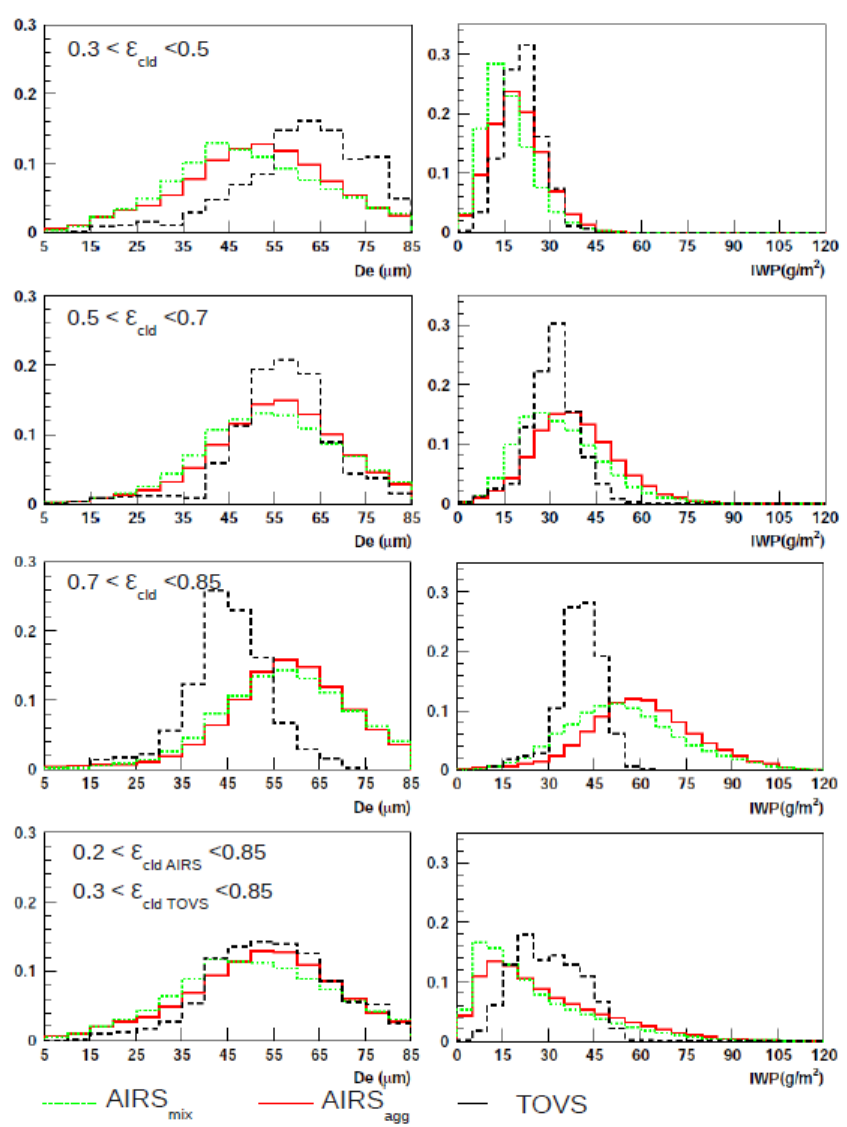
Fig. 14. Normalized frequency distributions of D e (left) and IWP (right) retrieved from TOVS (dashed black lines) and from AIRS observations (dotted green), separately for different cirrus emissivity intervals. Statistics is over 1987–1990 and 2003–2009, respectively. In addition, the AIRS retrieval has been performed with only two channels and using the same single scattering properties as in the TOVS retrieval (full red lines).